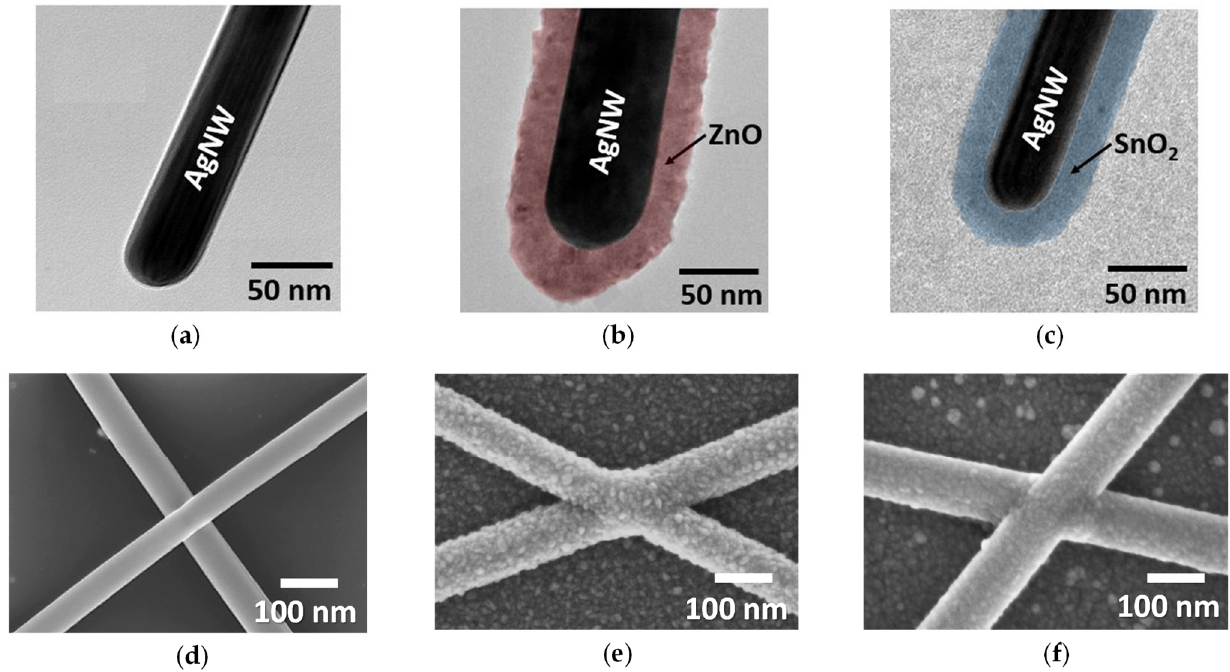
Figure 5. Coating AgNWs with thin oxide films by AP-SALD. TEM observations of ( a ) bare AgNW; ( b ) ZnO/AgNW and ( c ) SnO 2 /AgNW nanocomposites. SEM observations of ( d ) bare AgNW; ( e ) ZnO/AgNW and ( f ) SnO 2 /AgNW nanocomposites. The ZnO and SnO 2 coating thicknesses around the AgNWs were about 25 nm.